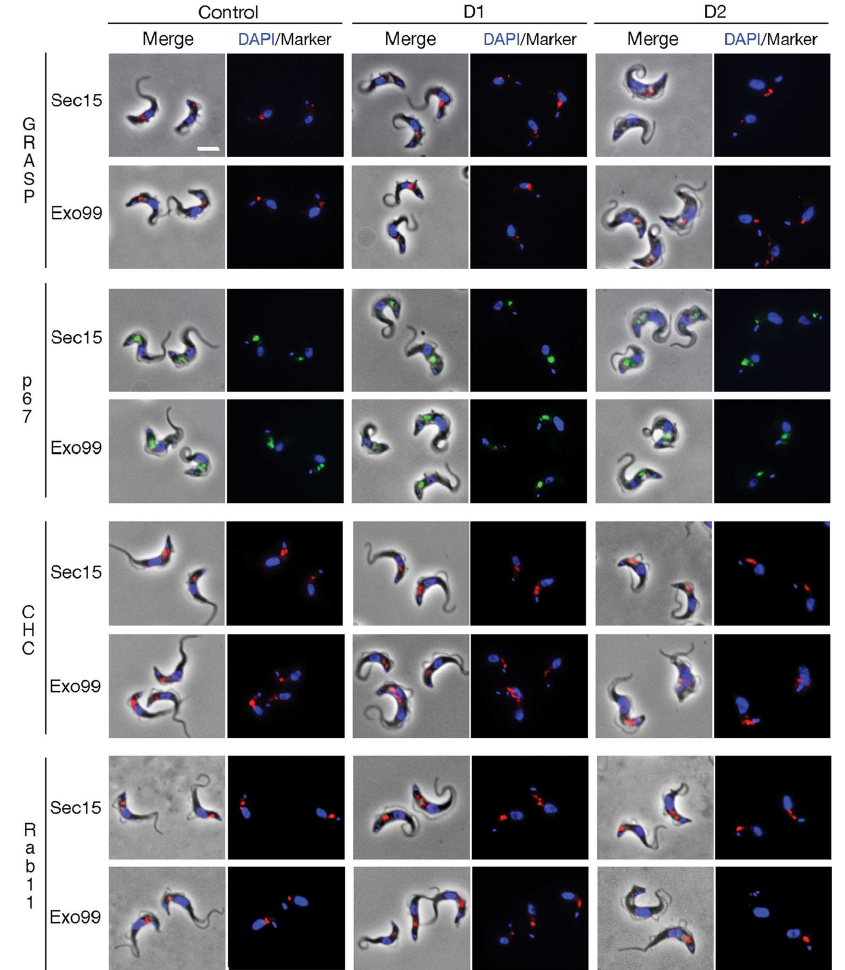
Fig 3. The exocystis not requiredfor endomembrane systemmaintenanceor morphology. Immuno- fluorescence microscopyanalysisof selectedorganellemarkersor traffickingpathwaysfor Sec15::RNAiand Exo99::RNAi cells at 24 (D1) and48h(D2)post induction.Cellswerestainedwithspecificantibodiesagainst GRASP (red),p67(green),clathrinheavychain(red)or Rab11(red) andcounter-stained withDAPI to visualise DNA (blue).The morphologyandproteinexpressionlevelsof allmolecularmarkersremainedstable.Scalebar, 5 μ